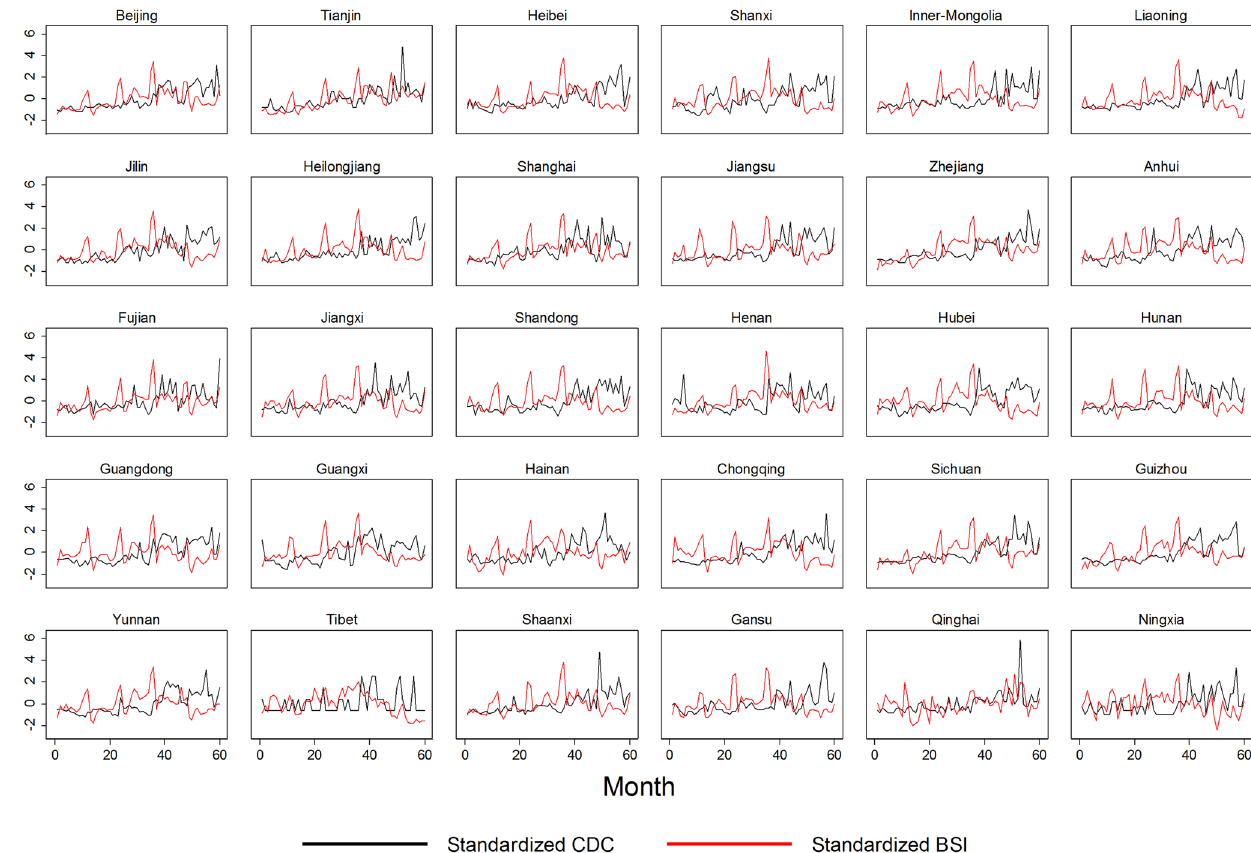
Figure 2. Standardized monthly HIV/AIDS incidence and BSI by province, January 2009–December 2013.